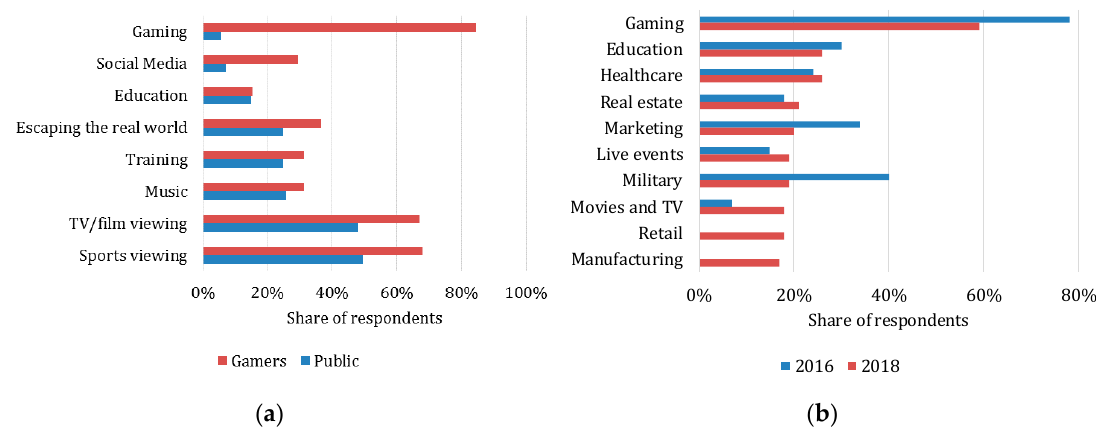
Figure 3. Trends of the virtual world market: ( a ) ranking of purposes of use for virtual reality in 2015; ( b ) investment directions of virtual / augmented reality technology worldwide in 2016 and